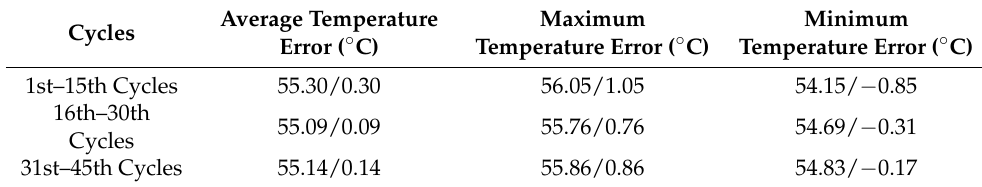
Table A5. Experimental results of liquid temperature at annealing